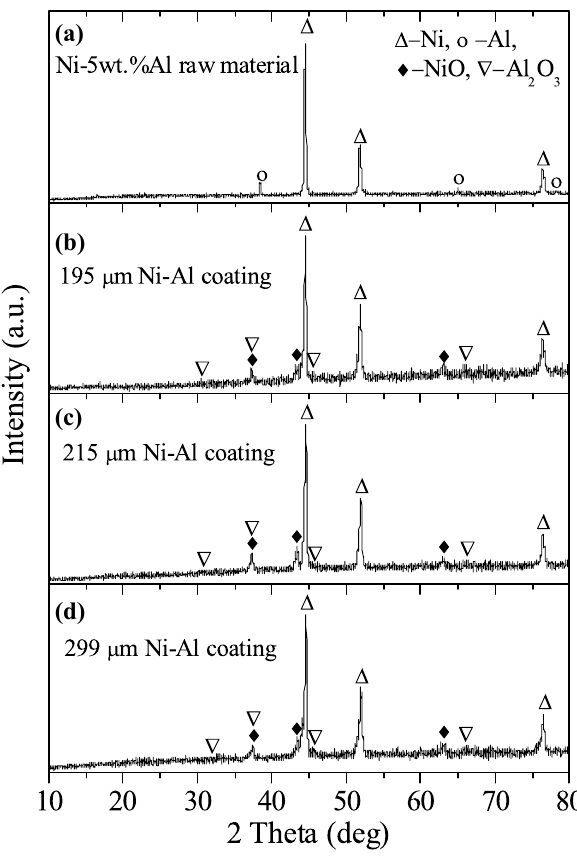
Fig. 6 The XRD pattern of a Ni-5wt%Al raw material, and b – d Ni– Al coating with different thicknesses of 195, 215 and 299 µm, respec- tively